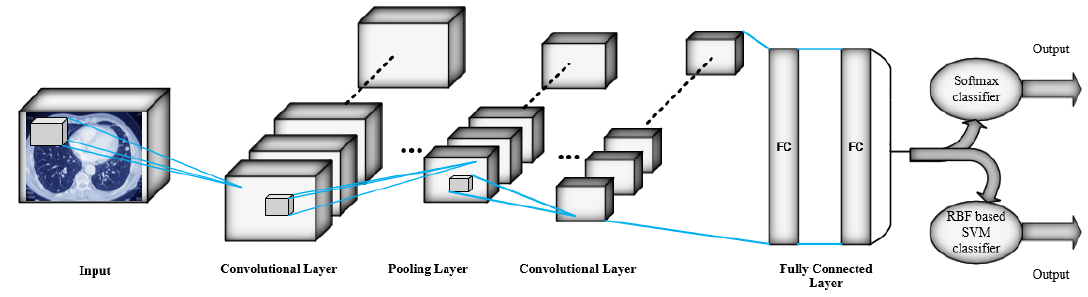
Figure 4. Architecture of the two proposed 3D-CNN. Table 1. Summary of two proposed 3D-CNN architectures in the classification of lung CT scan images.